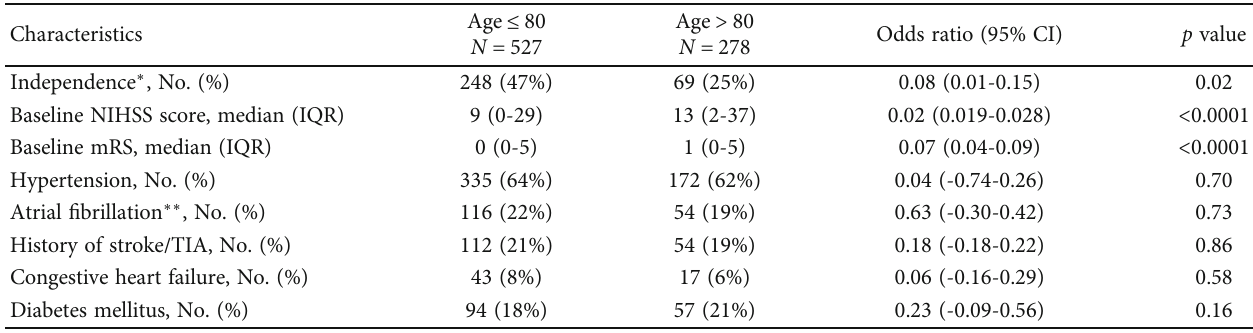
Table 3: Independence at hospital